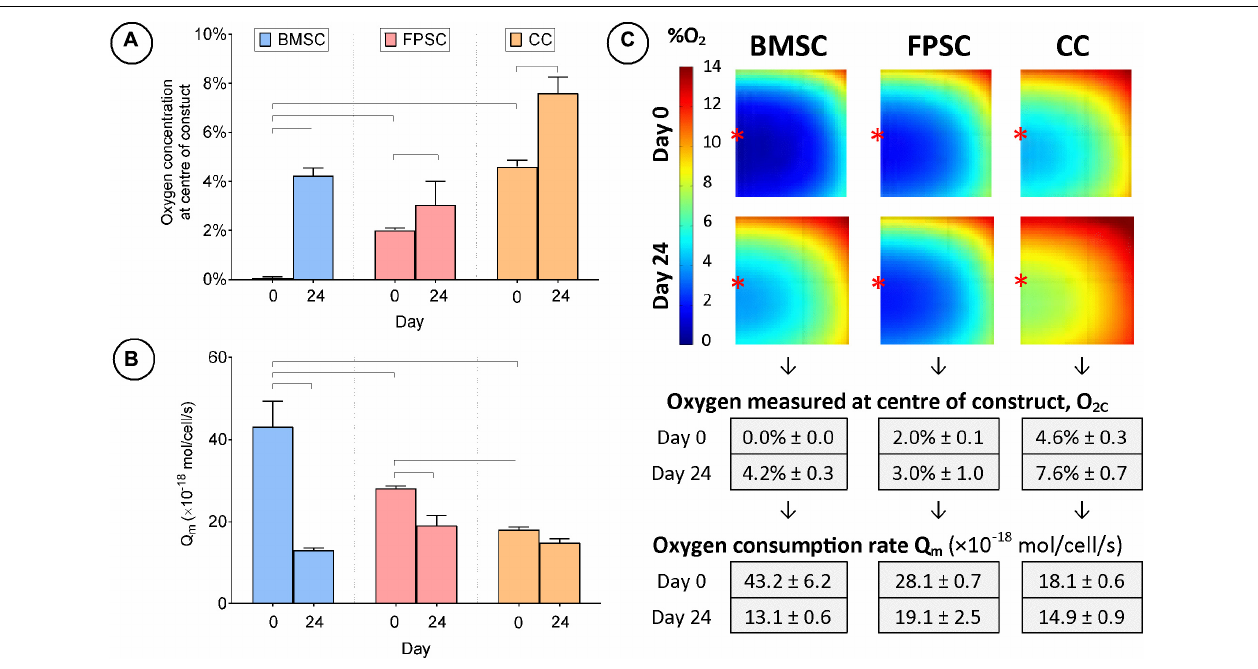
FIGURE 3 | Cartilage tissue grafts engineered using various cell sources were cultured for 24 days. (A) Oxygen concentration at center of constructs. (B) Cellular oxygen consumption rate extrapolated from FE model. (C) FE contour plots showing predicted oxygen gradients and table of values from (A,B) ( ± SD). Significant differences between groups are indicated where P < 0.05 ( n = 3). ∗ Indicates the location of oxygen sensor measurement within the constructs.